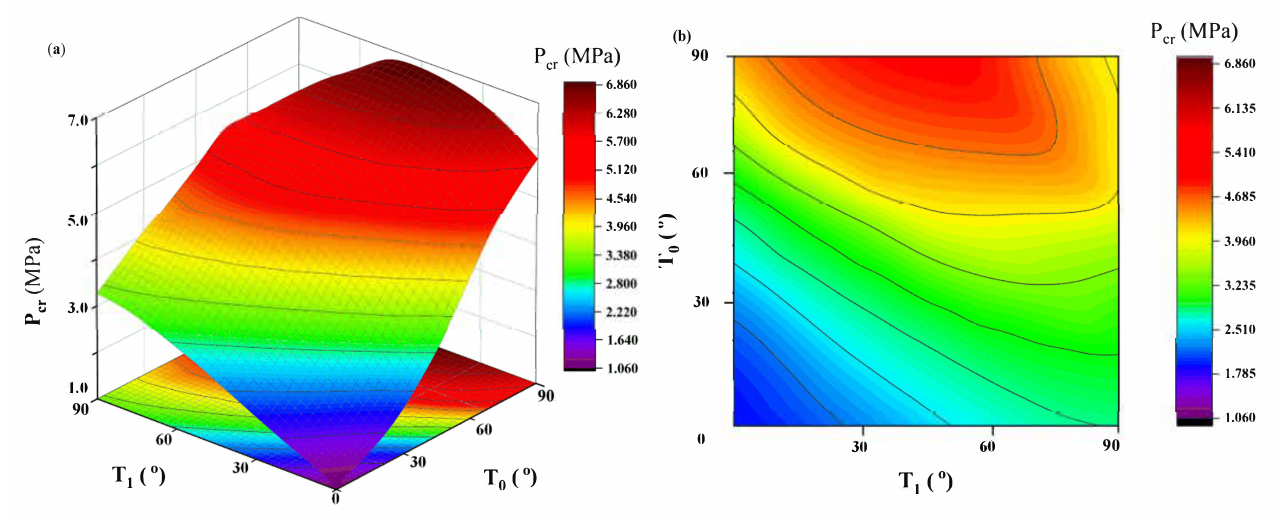
Figure 8. The contour map of RBF test surrogate model for P cr : ( a ) 3D and ( b ) 2D.